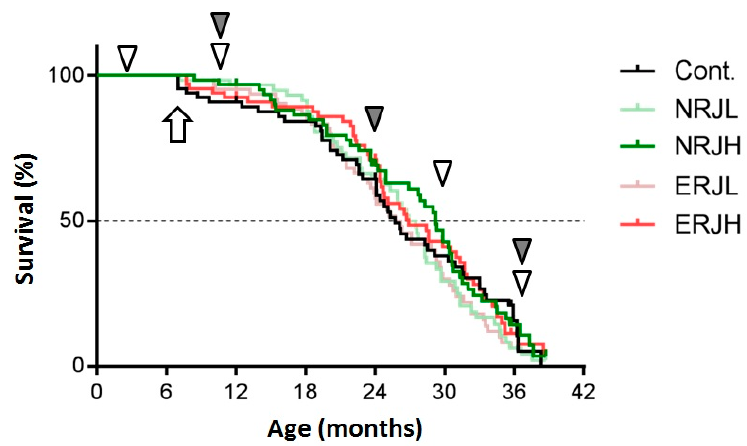
Figure 1. A comparison of the survival curves between control and royal jelly (RJ)-treated mice. A Kaplan–Meier analysis was used to estimate the median lifespan. The arrow indicates the beginning of the RJ treatment. The white arrowheads indicate the time at which mice physical performance was tested. The gray arrowheads indicate the time at which the mice were sacrificed to obtain samples for the experiments. Cont: control; NRJL: enzyme-untreated RJ low-dose; NRJH: enzyme-untreated RJ high-dose; ERJL: enzyme-treated RJ low-dose; ERJH: enzyme-treated RJ low